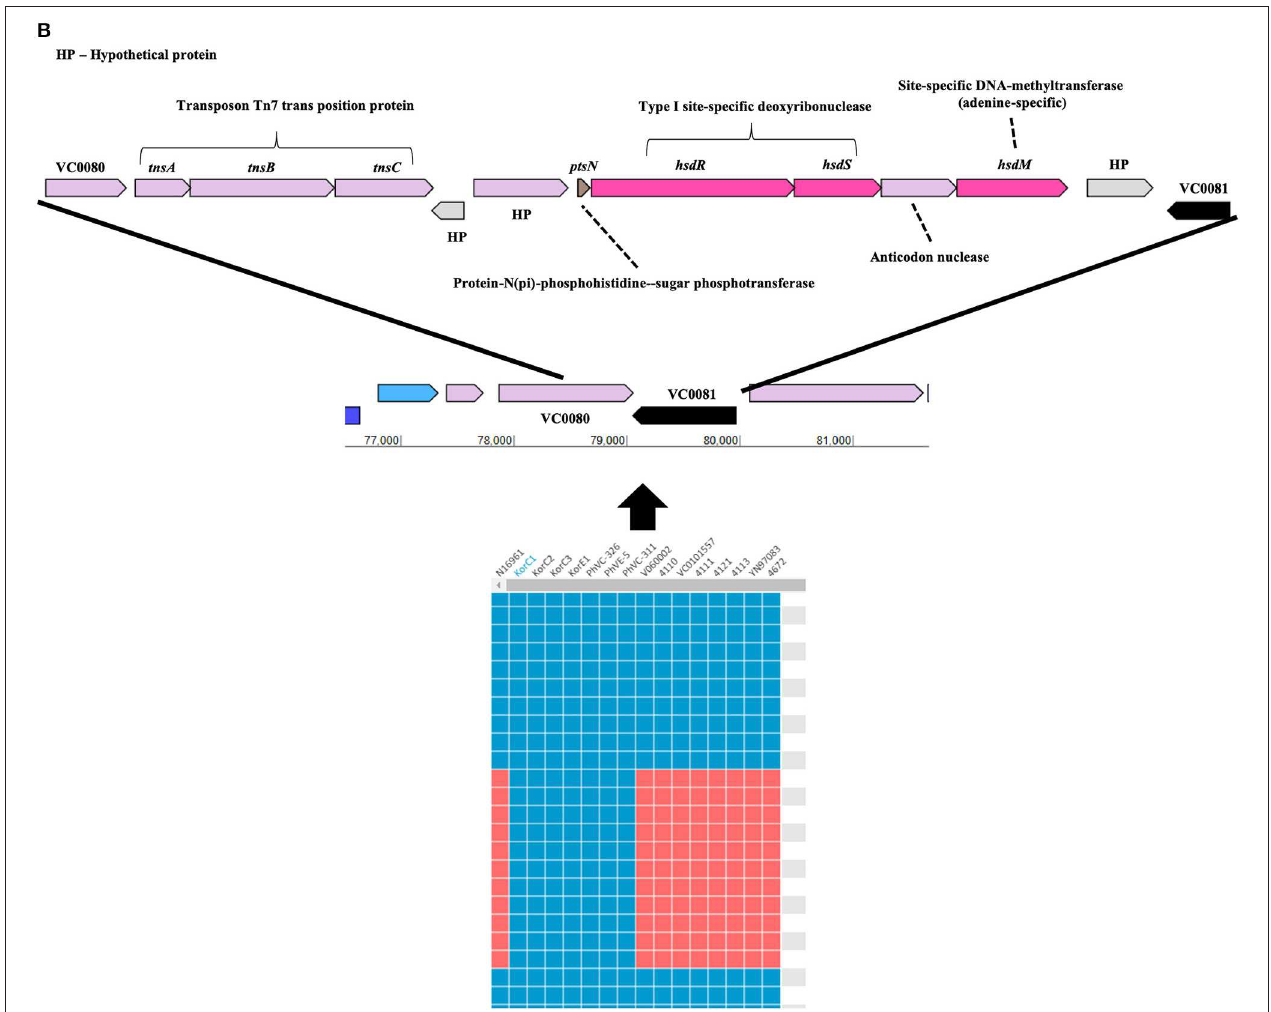
FIGURE 3 | Genomic islands that are uniquely present in both Korean and Phillipinnes outbreak strains. Boxes in blue and red indicate the presence and absence, respectively, of the orthologous gene in the genome to genome comparison. HP, hypothetical protein. (A) Genomic island 1 is located between VC0424 and VC0425. (B) Genomic island 2 between VC0080 and VC0081. Both genomics islands contain Type I specific deoxyribonucleases and adenine-specific DNA-methyltransferase.